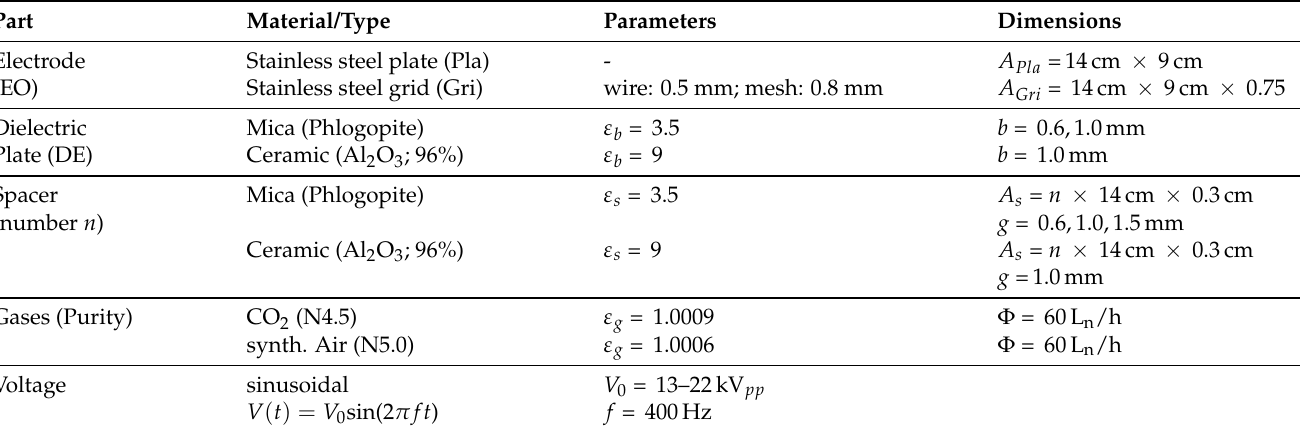
Table 1. Parameters of DBD arrangement and